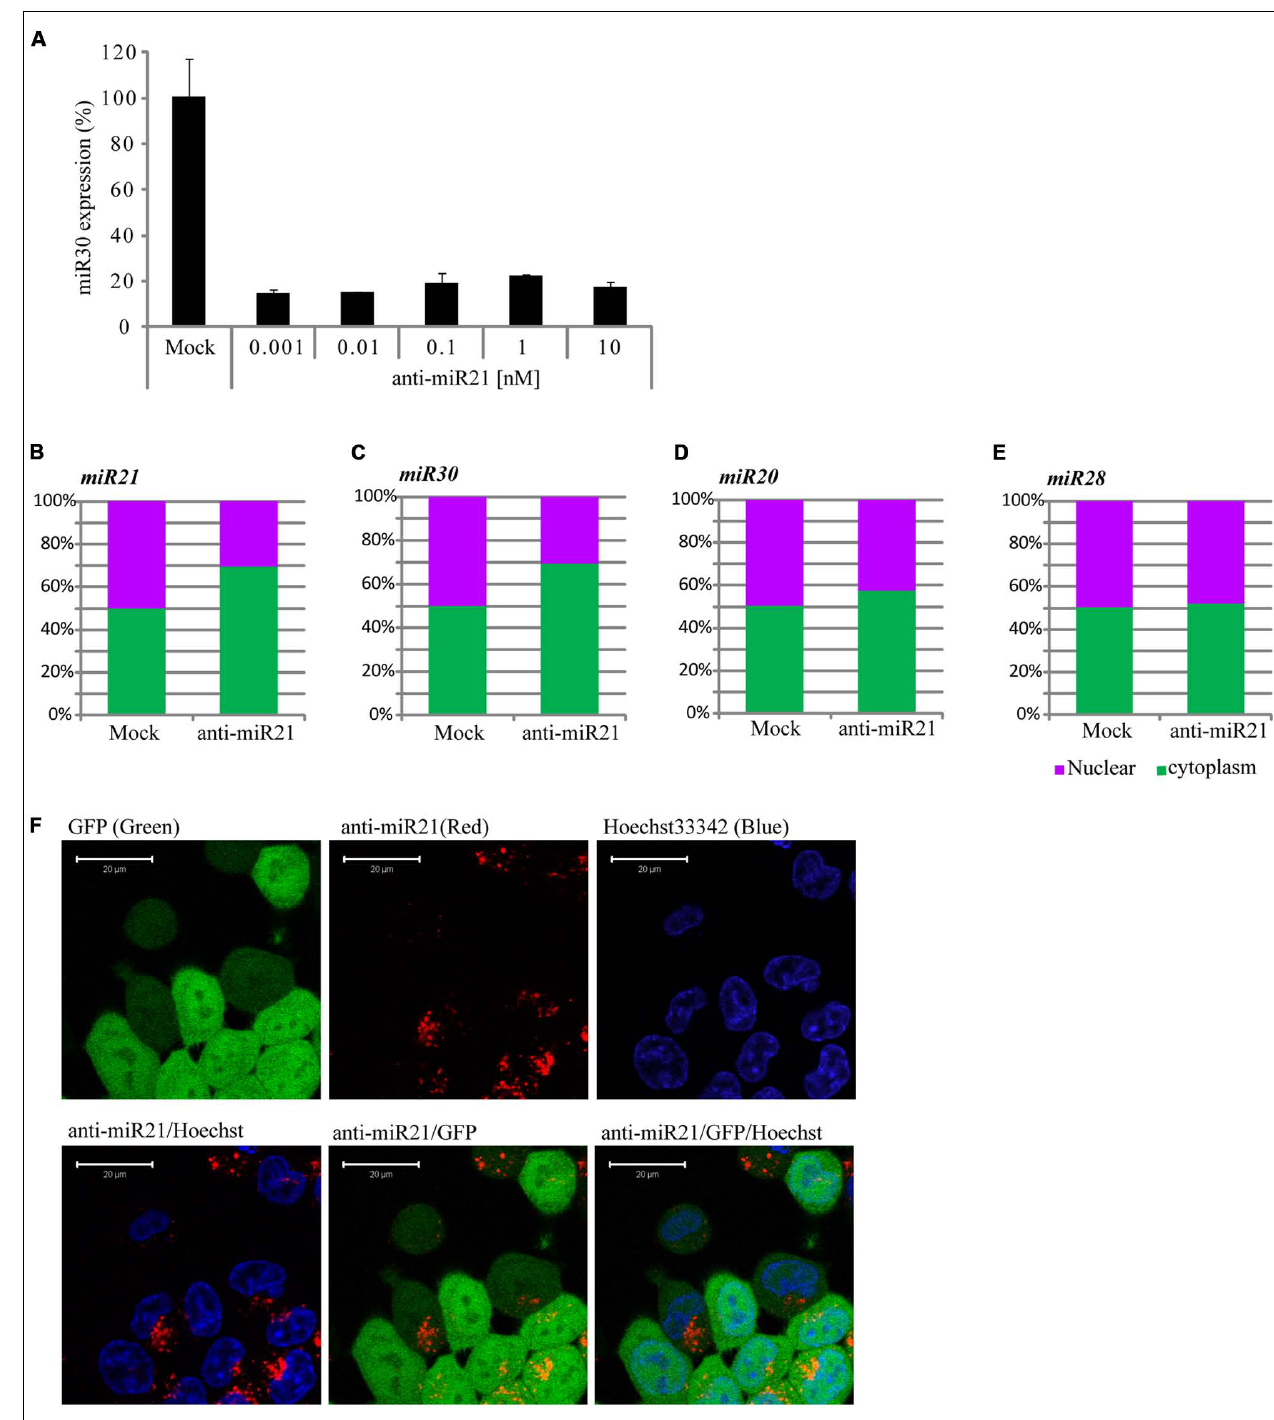
FIGURE 4 |Anti-miR21 changes the localization of miR30. (A) Abundance of miR30 in HCT116-GFP cells transfected with anti-miR21 (0.01–10 nM), as measured by real-time qPCR. Cytoplasmic or nuclear localization of miR21 (B) , miR30 (C) , miR20 (D) , and miR28 (E) in cells transfected with anti-miR21